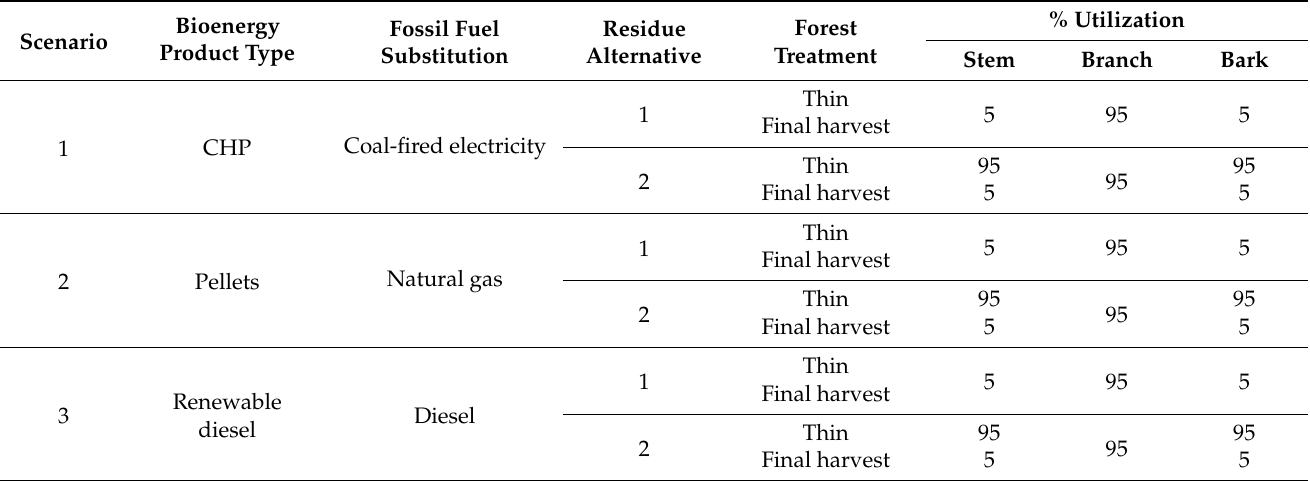
Table 1. Summary of bioenergy type, fossil fuel substitution, and tree fraction utilization of the different scenarios and residue utilization